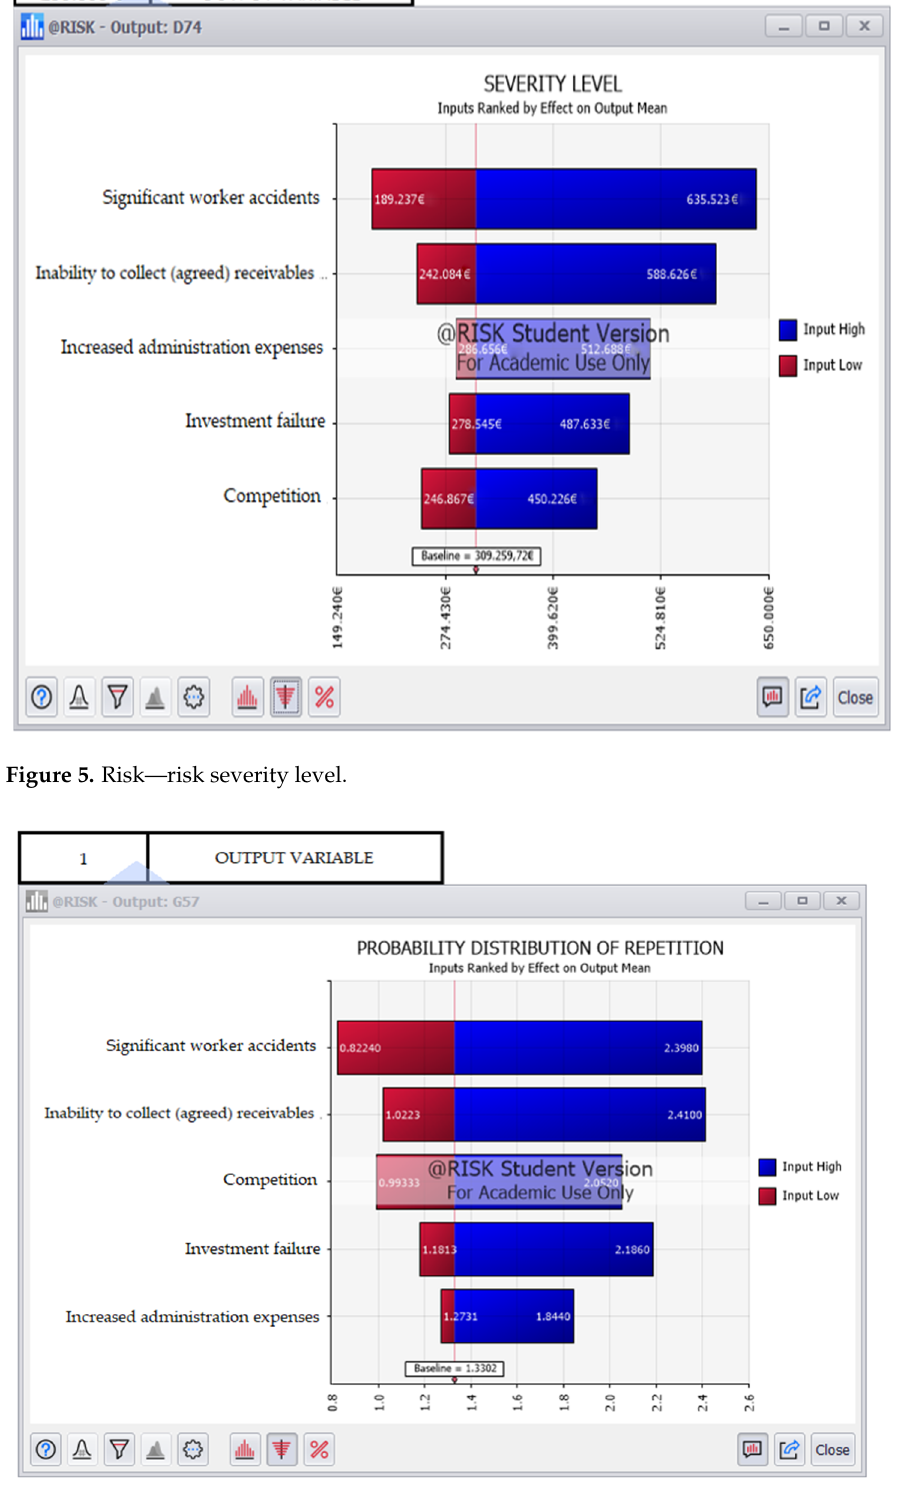
Figure 6. Risk—tornado chart for total risk occurrence number.